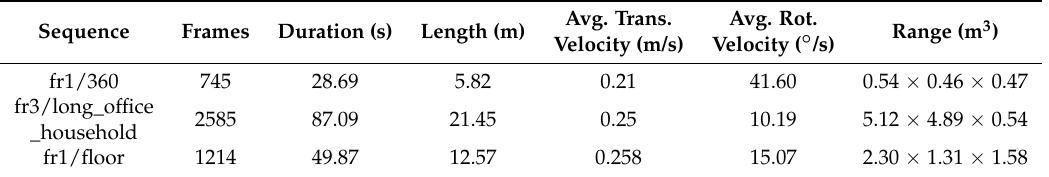
Table 1. Details of sequences from the Red Green Blue-Depth (RGB-D) Simultaneously Localization And Mapping (SLAM) dataset